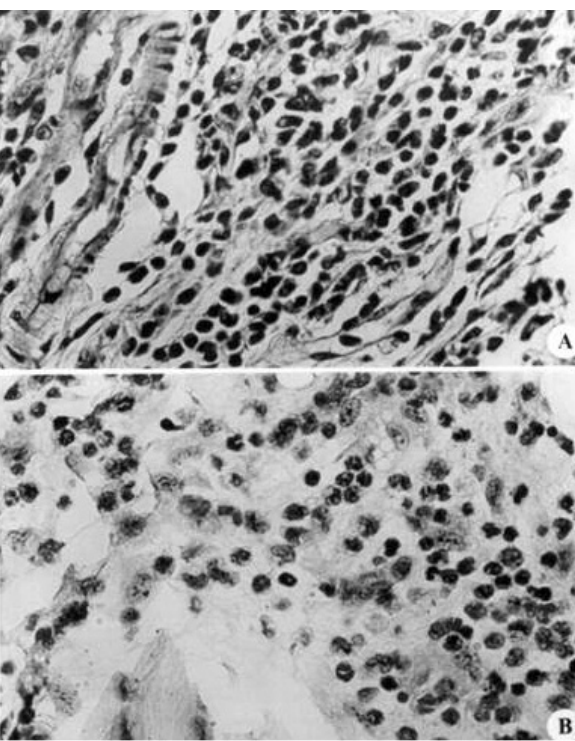
Figure 3. Electrophoretic analysis of 4d CFAg and 11d CFAg. Fifty-four microgram each of 4d CFAg and 11d CFAg were separated by SDS-PAGE under reducing conditions in a 7-14 continuous gradient gel. The bands were visualized by silver staining for glycoproteins. ( a ) 4d CFAg; ( b ) 11d CFAg; ( c ) molecular weight standard